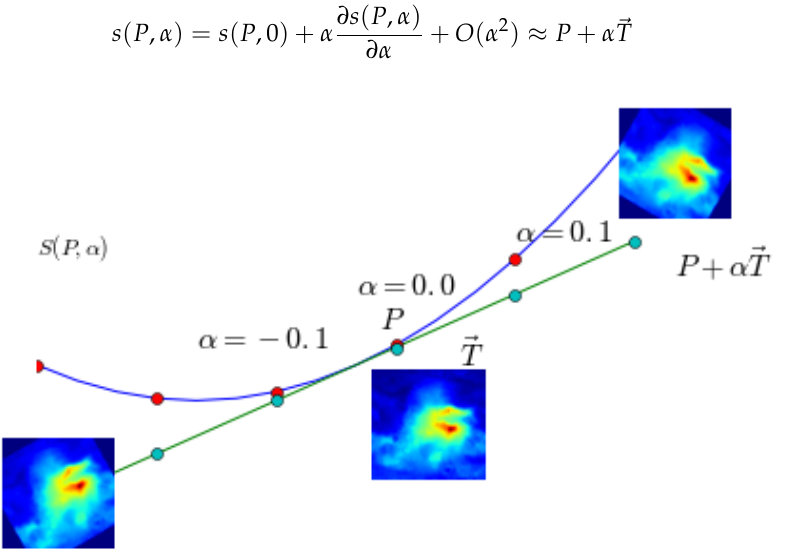
Figure 3. Tangent space to the Manifold of the map at “2016-01-19 10:30:00 (Year-Month-Day